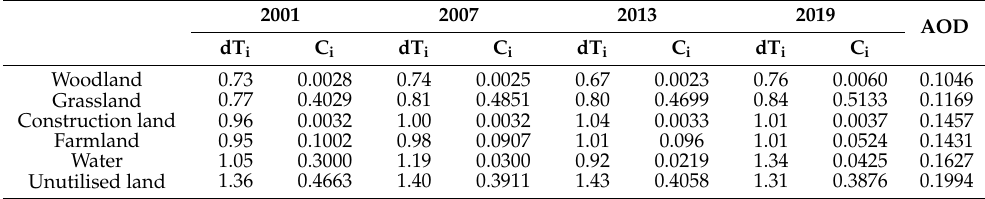
Table 3. Difference and contribution of the average AOD of different land use